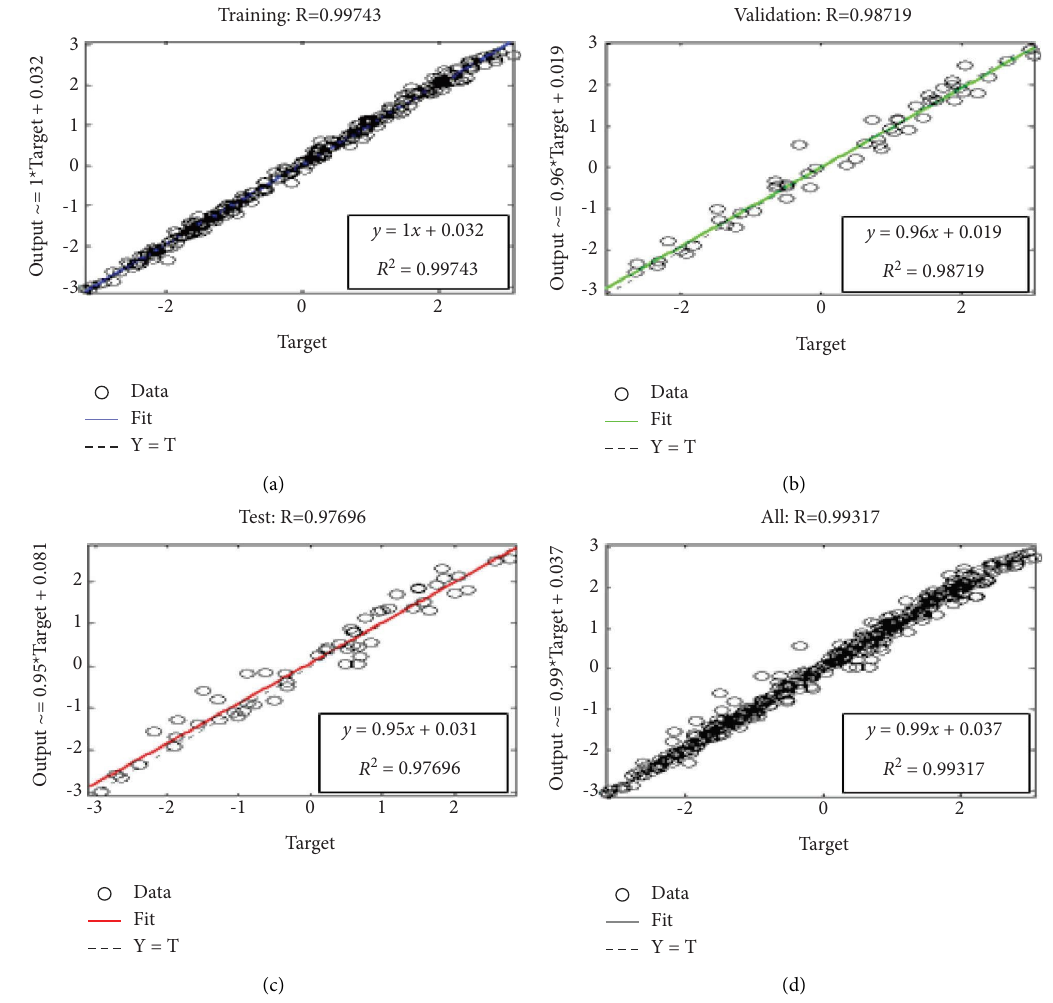
Figure 3: Regression plot for ANN. (a) Training: R � 0.99743. (b) Validation: R � 0.98719. (c) Test: R � 0.97696. (d) All: R � 0.99317.